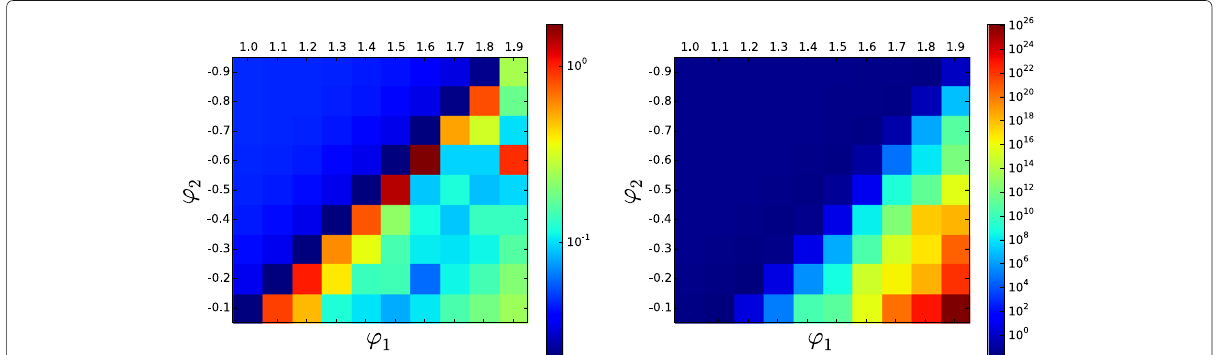
Fig. 6 Root-mean-square deviation between estimated and true values of active power at bus 6 for various initial ARMA(2,0) parameters (ϕ 1 , ϕ 2 ) . Left: Results for the NLO with online learning technique. Right: Results for the NLO with fixed ARMA(2,0) parameters